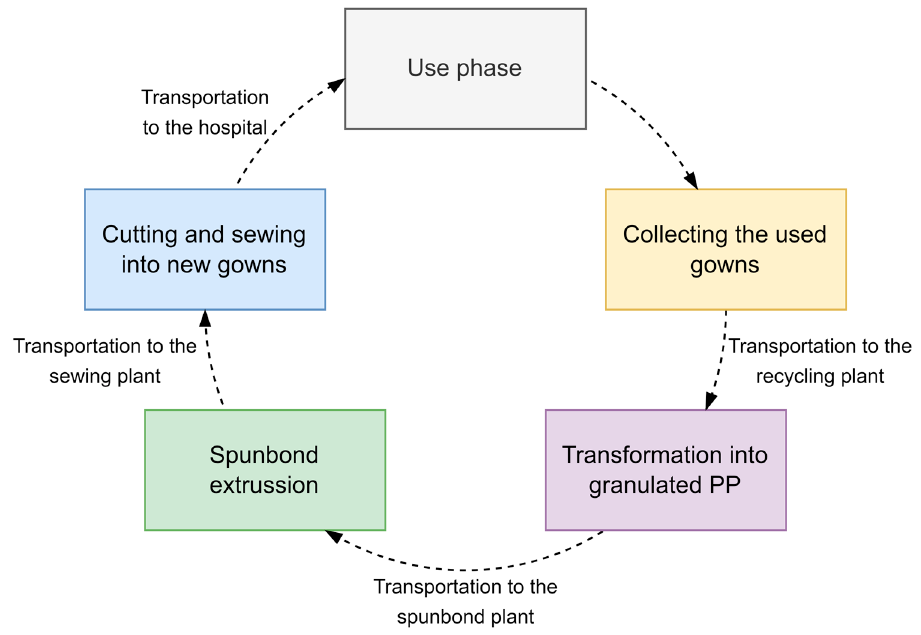
Figure 4. Preliminary design of the circular economy mode.